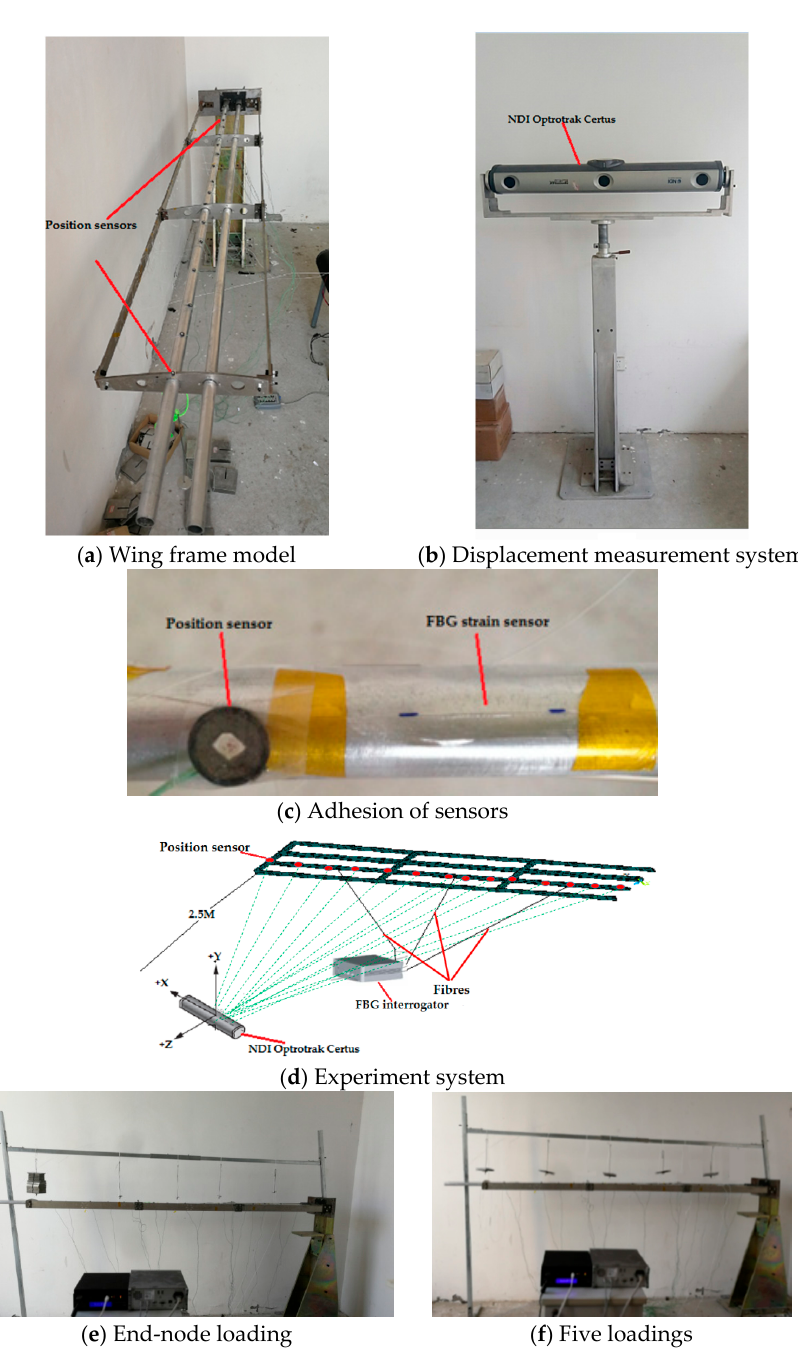
Figure 8. Wing frame model tests.